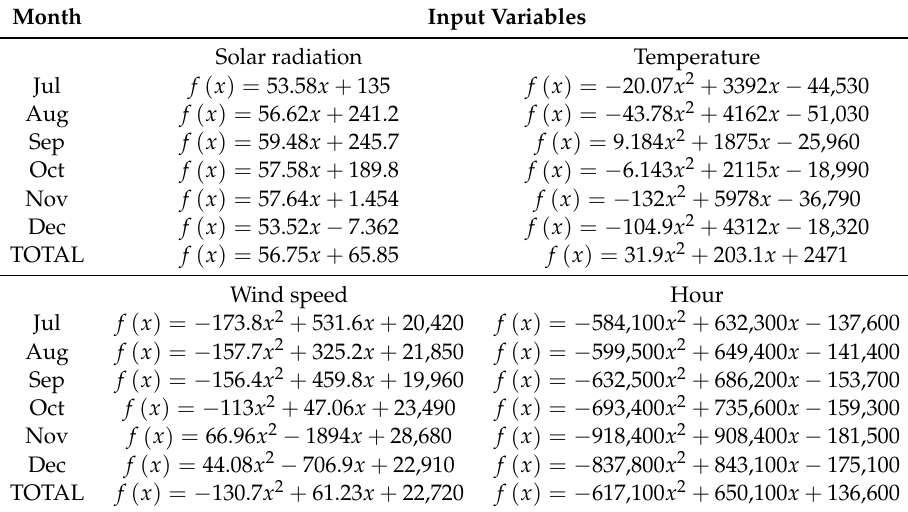
Table 5. The fitted curve characteristic equation of every input from MCS.